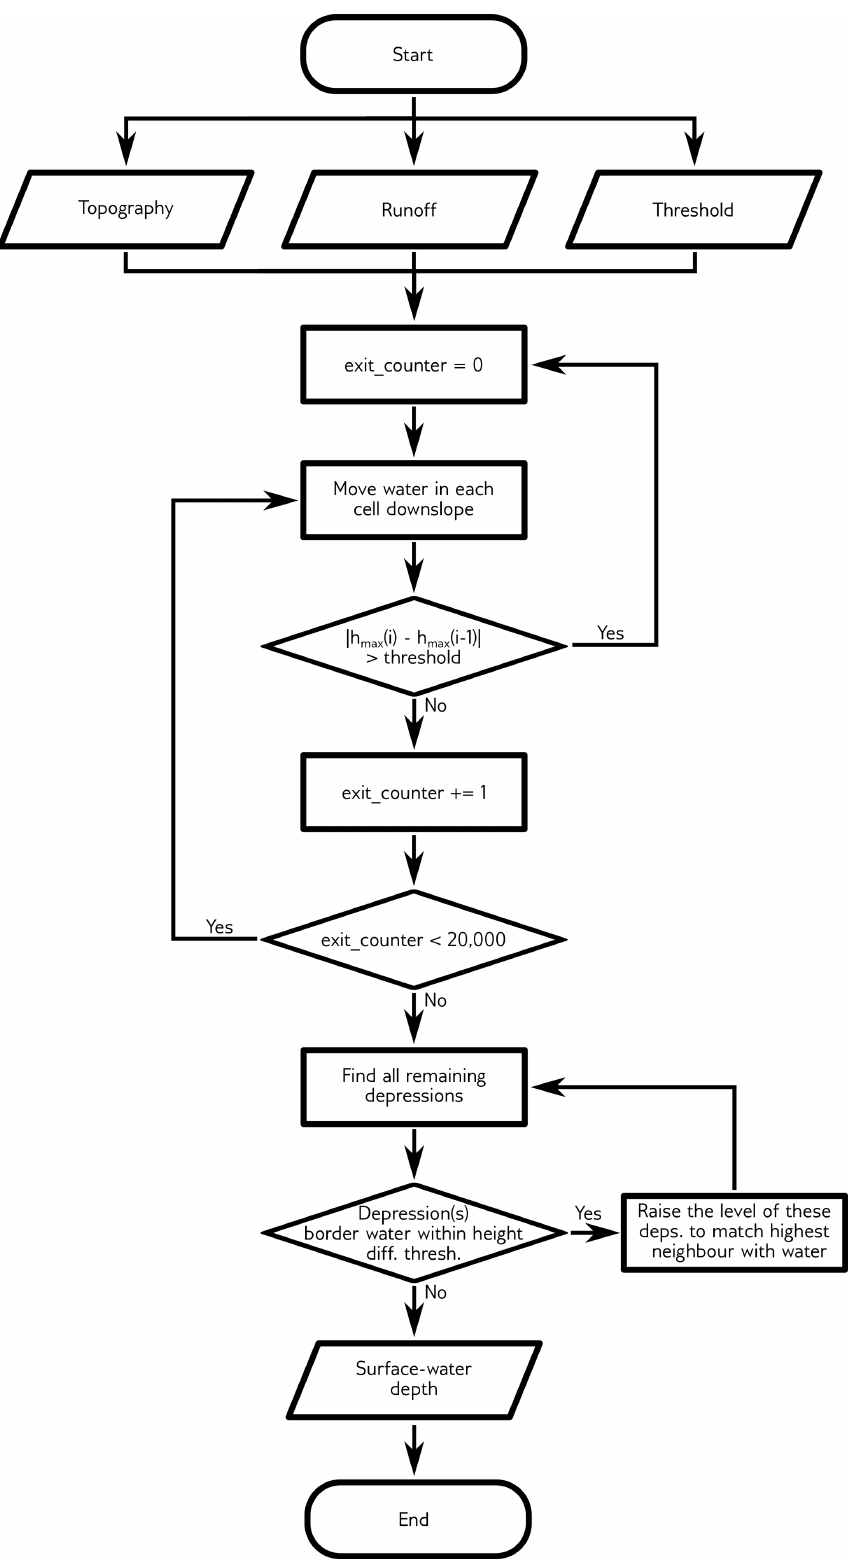
Figure 2. FlowFill flowchart; h max is the maximum amount of water moved from a single cell to another during each iteration ( i ). The majority of the runtime is spent moving water from each target cell to those